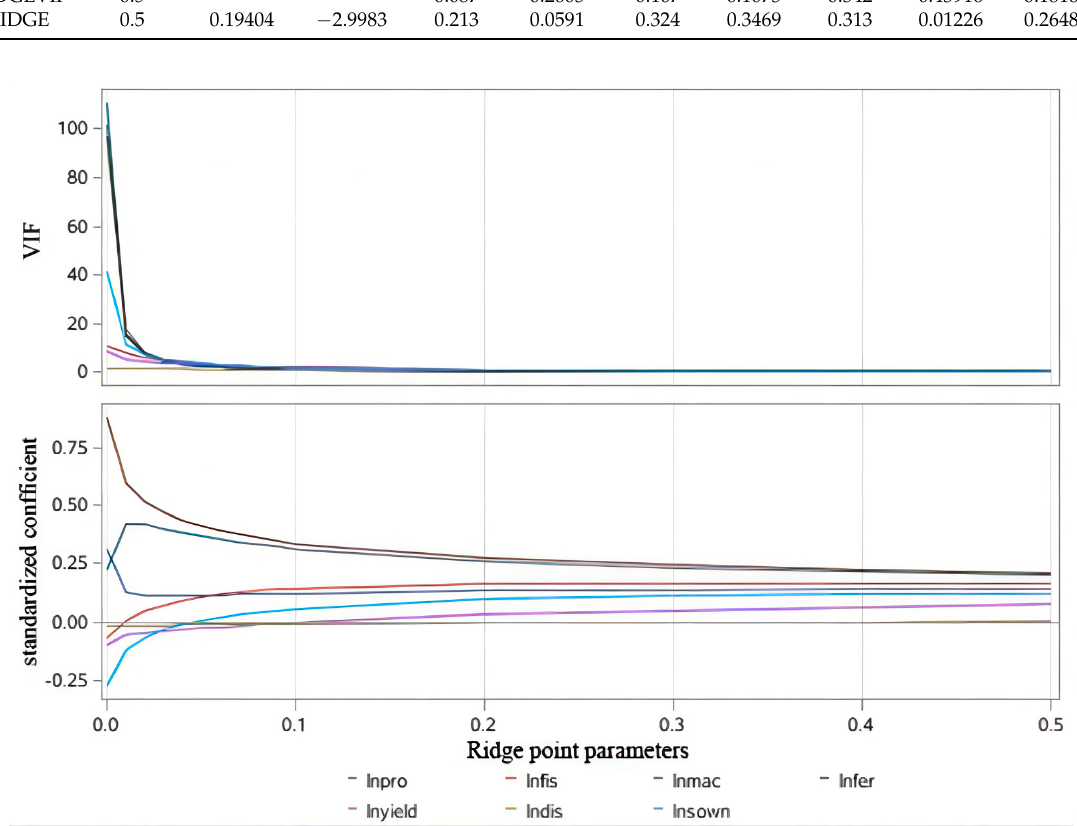
Figure 6. Ridge trace for the agricultural output value.